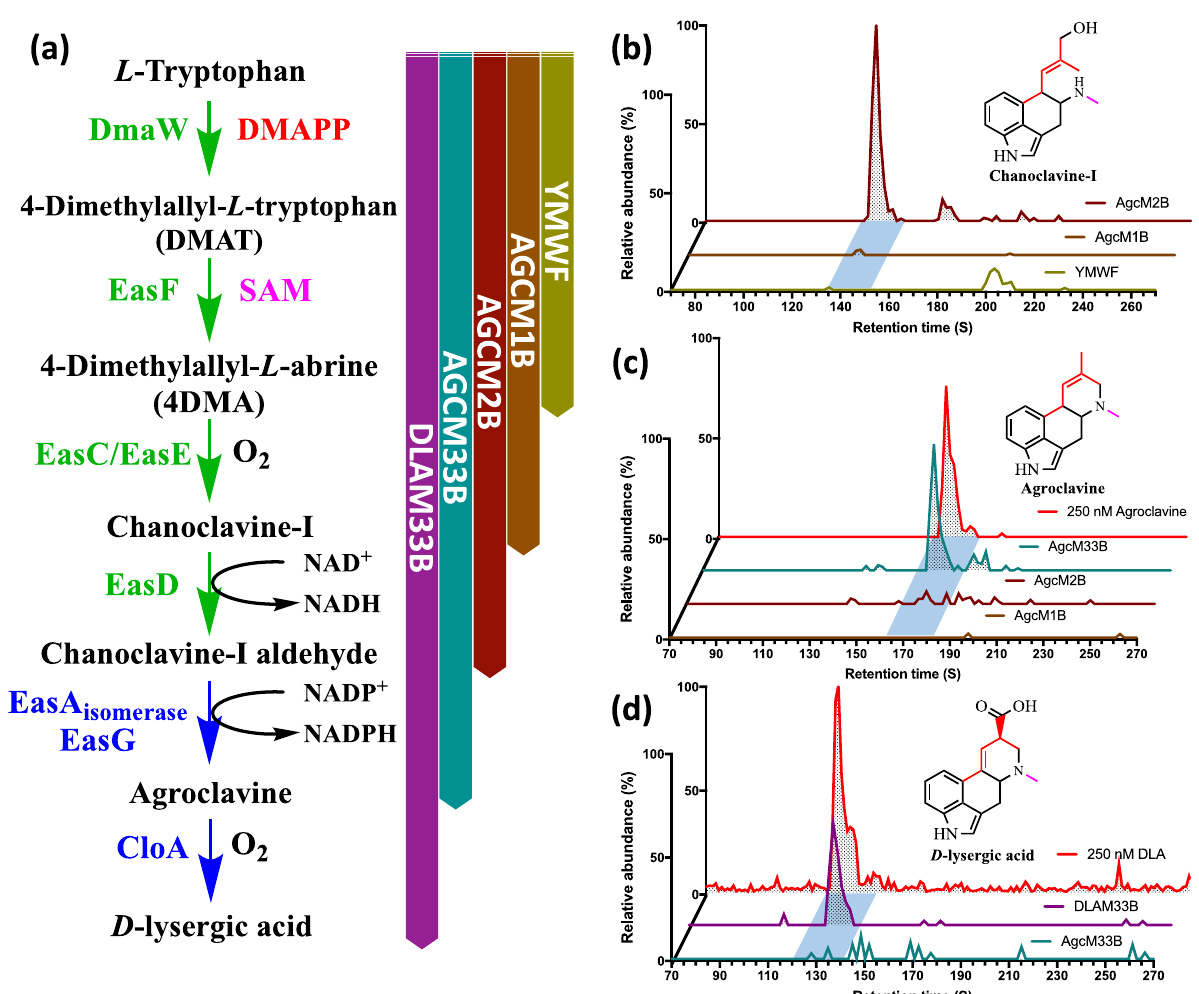
Fig. 5 Assembling the functional parts into a DLA-producing yeast strain. a Stepwise extension approach towards pathway construction in our engineered strains, enabling the use of each prior strain as a control for subsequent strains. b LC-MS/MS extracted ion chromatogram monitoring for the ion transition of [M + H] + = 257 → 226 m/z, showing the production of chanoclavine-I in both AgcM1B and AgcM2B. c LC-MS/MS extracted ion chromatogram for the ion transition of [M + H] + = 239 → 208 m/z, showing the production of agroclavine from AgcM33B. d LC-MS/MS extracted ion chromatogram showing the detected ion transition of [M + H] + = 269 → 223 m/z, showing the production of DLA from DLAM33B. Peaks eluted at the time segments in blue correspond to the targeted compounds. Source data are provided as a Source Data fi